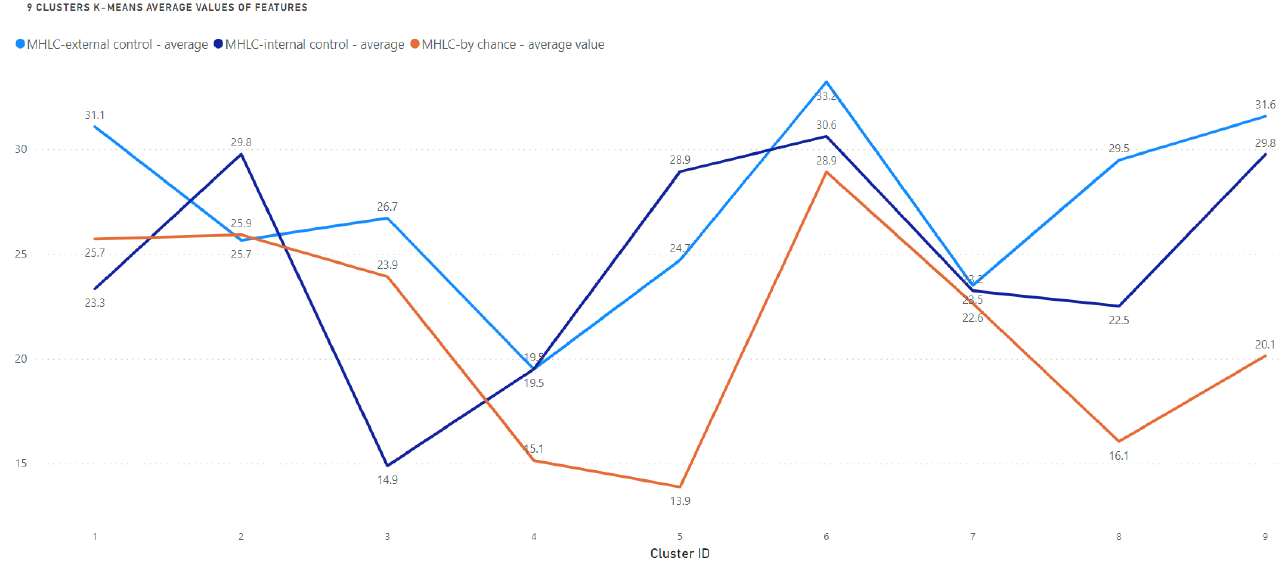
Figure 5. Average values of features among clusters.